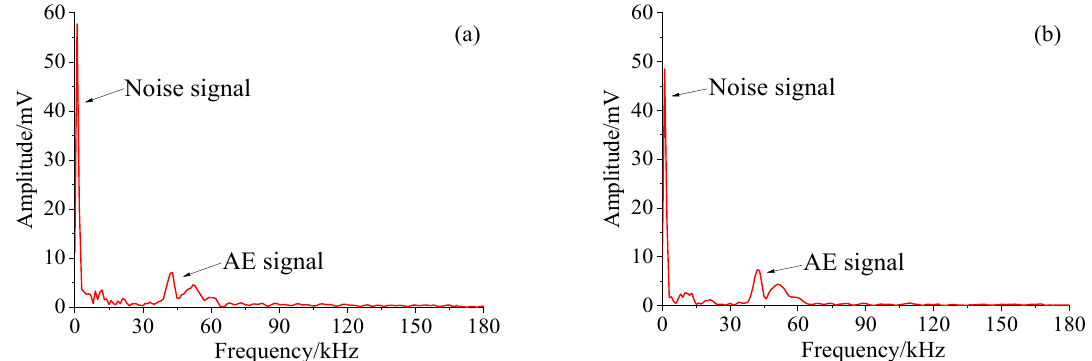
Figure 15. Frequency spectrum of AE by the AST method: ( a ) Excitation sensor 1; ( b ) excitation sensor 2.